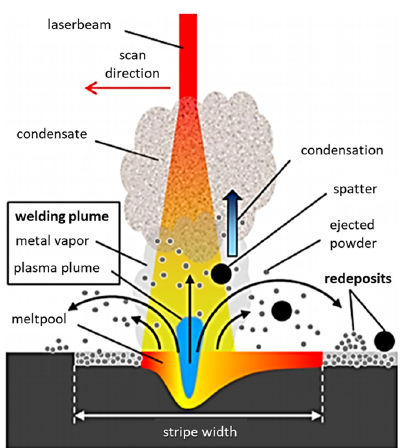
Figure 16. Spatter and other by-products pass through the laser stream and squander laser energy, condensate is the product of vaporized metal that quickly cools and condenses. (Reprinted with permission from Ref. [87]. Copyright 2016 Elsevier B.V.).